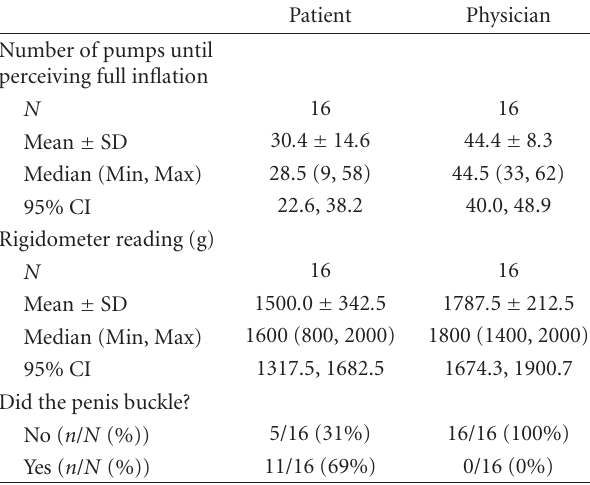
Table 4: Physician feedback. Table 5: Rigidity